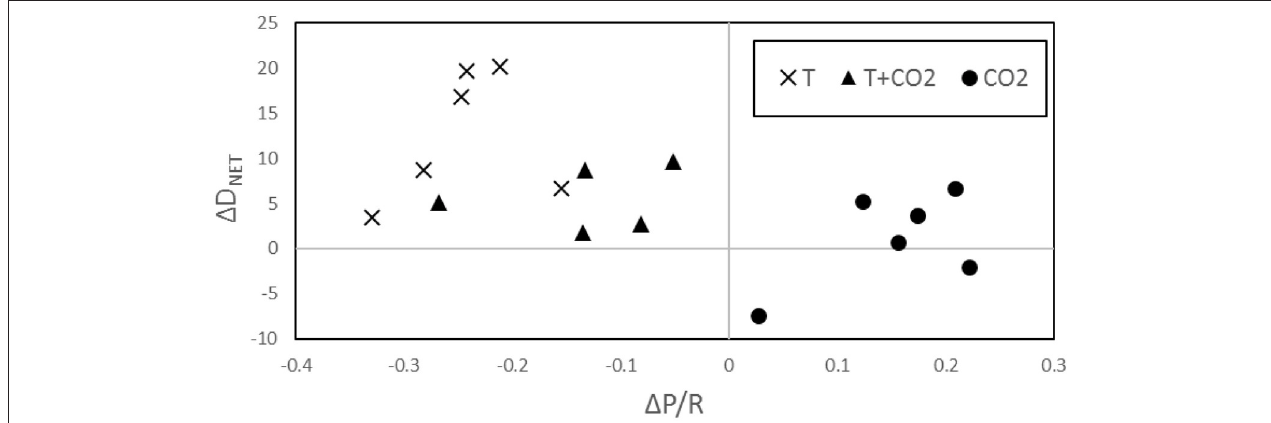
FIGURE 5 | Plot of 1 D NET vs. 1 P/R for each